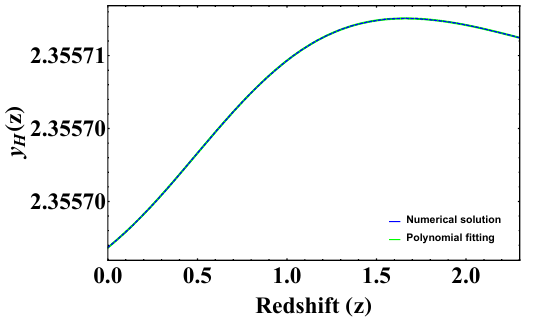
Figure 4. The numerical solution for Equation (35) (blue dashed curve) plotted together with its polynomial fitting (green continuous curve) in the case of F R 0 = − 10 − 7 . The assumption of a function of redshift in the form of a order-8 polynomial allows an accurate fit for the numerical values. The same fitting procedure has been used in the F R 0 = − 10 − 4 case.